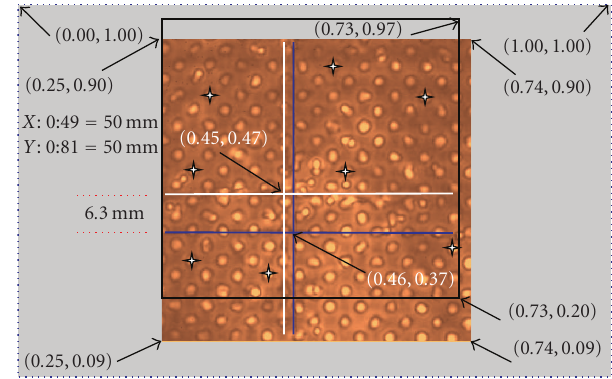
Figure 4: The normalized positions of similar points and the dis- tance between two crossed lines in VA and X-ray